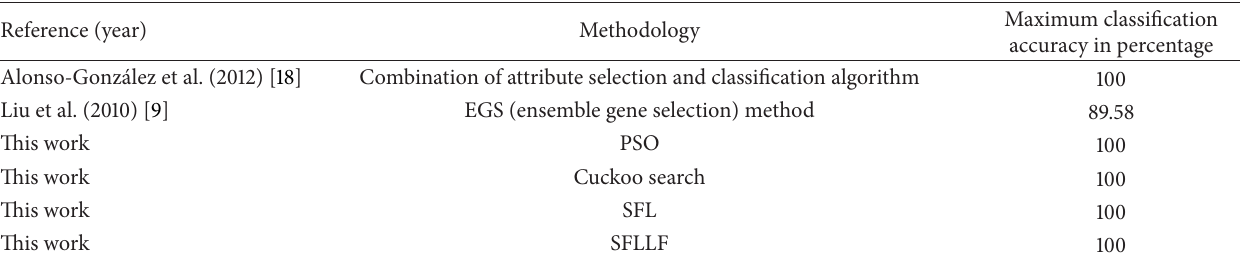
Table 7: Comparison of classification accuracy with other methods for Lung Cancer Michigan.